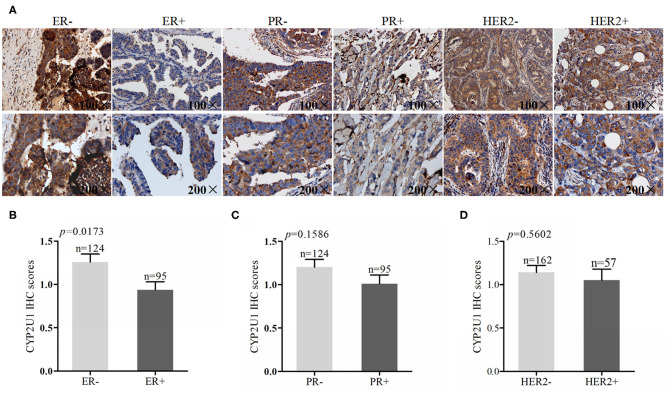
Analyses of CYP2U1 expression with status of ER, PR and HER2. (A) Representative images of CYP2U1 protein abundance in different status of ER, PR andHER2. (B) Semi-quantitative result of CYP2U1 protein abundance in ER-negative and ER-positive tumors tissue is displayed as the mean ± SEM. (C) Semi-quantitative result of CYP2U1 protein abundance in PR-negative and PR-positive tumors tissue is displayed as the mean ± SEM. (D) Semi-quantitative result about CYP2U1 protein abundance in HER2-negative and HER2-positive tumors tissue is displayed as the mean ± SEM.